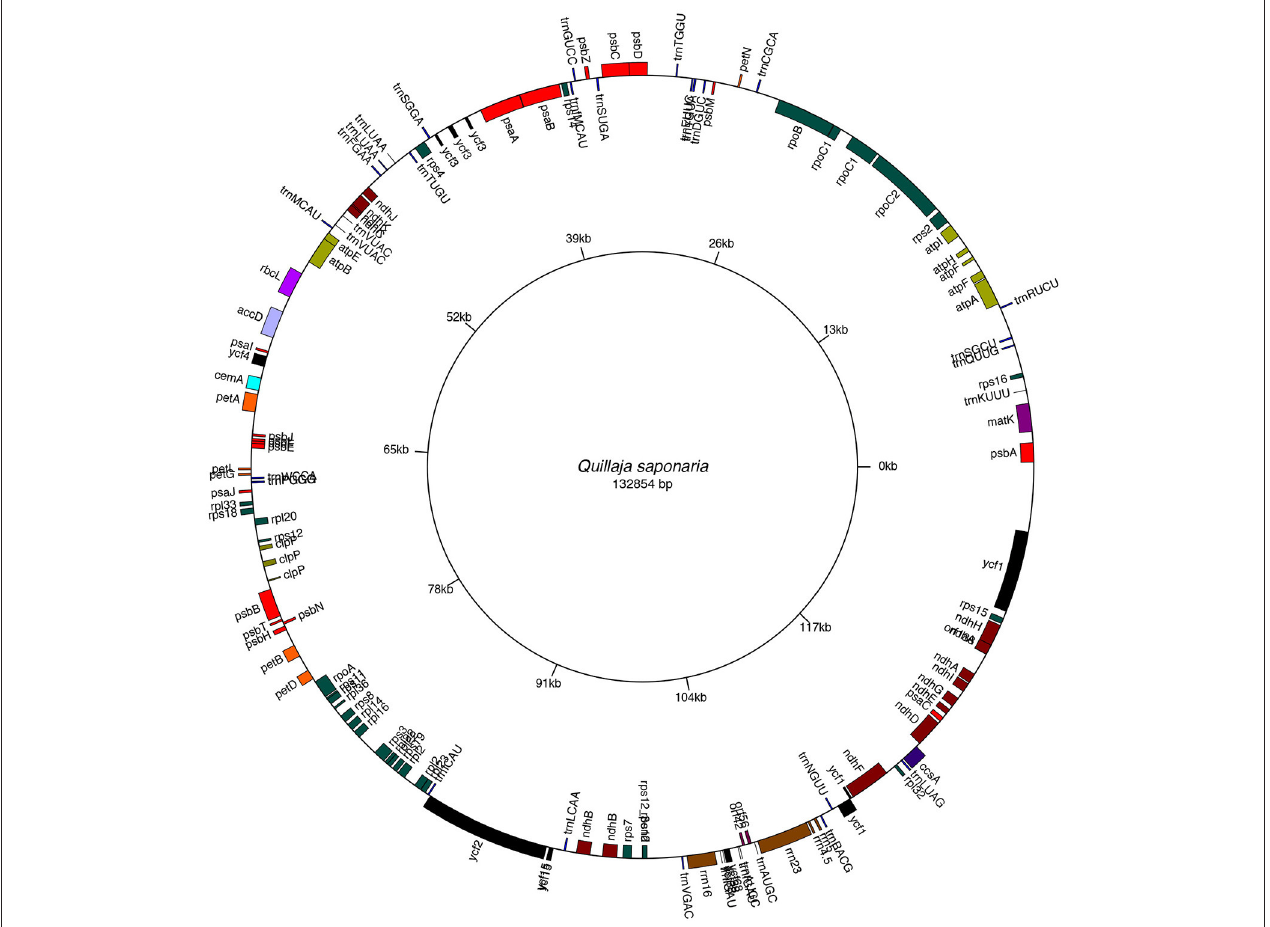
FIGURE 1 | Gene map of Quillaja saponaria cpDNA. Genes depicted within the map are transcribed in a clockwise direction. Genes on the outer part of the map are transcribed counterclockwise. Plastome map was drawn with the OrganellarGenomeDRAW (OGDRAW) program. See GenBank accession no MH880827.